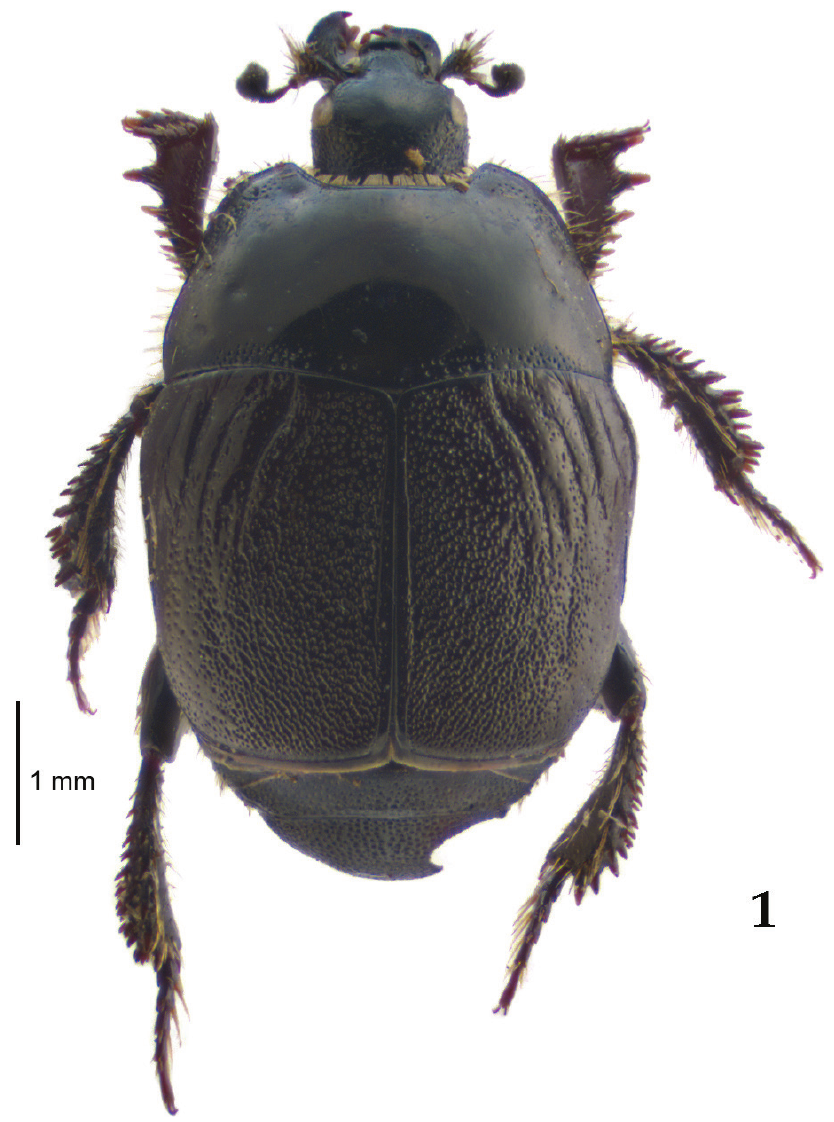
Figure 1. Australopachylopus lepidulus (Broun, 1881) comb. n., habitus, dorsal view.